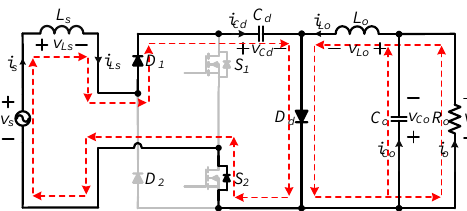
Figure 7. Equivalent circuit of the bridgeless Cuk converter in State 3 during positive half line cycle.